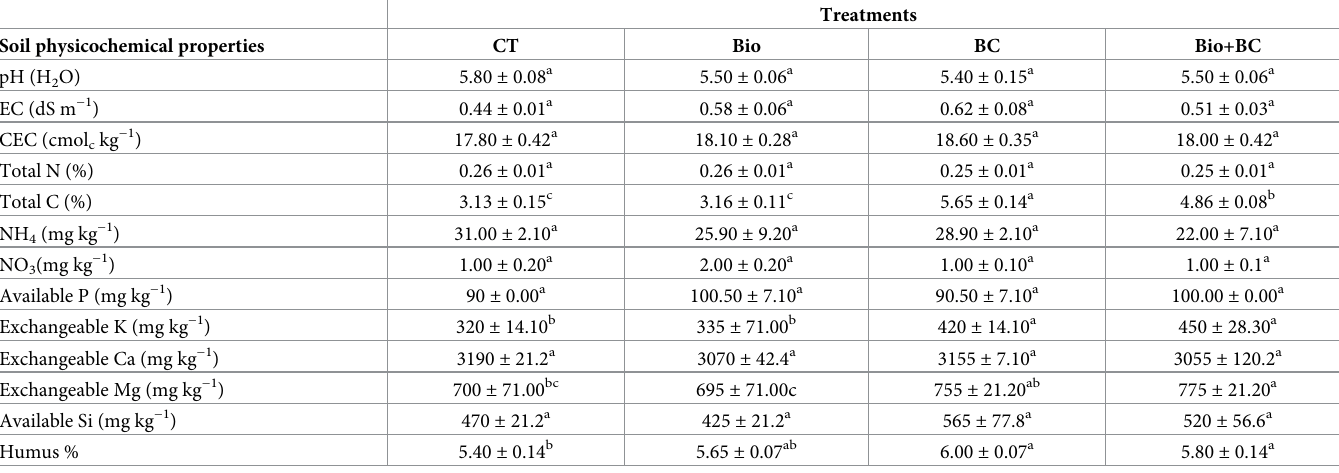
Table 2. Soil physicochemical properties after rice cultivation.